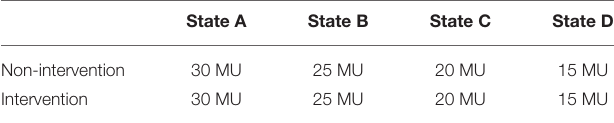
TABLE 5 | Indirect costs (per neighborhood and year).